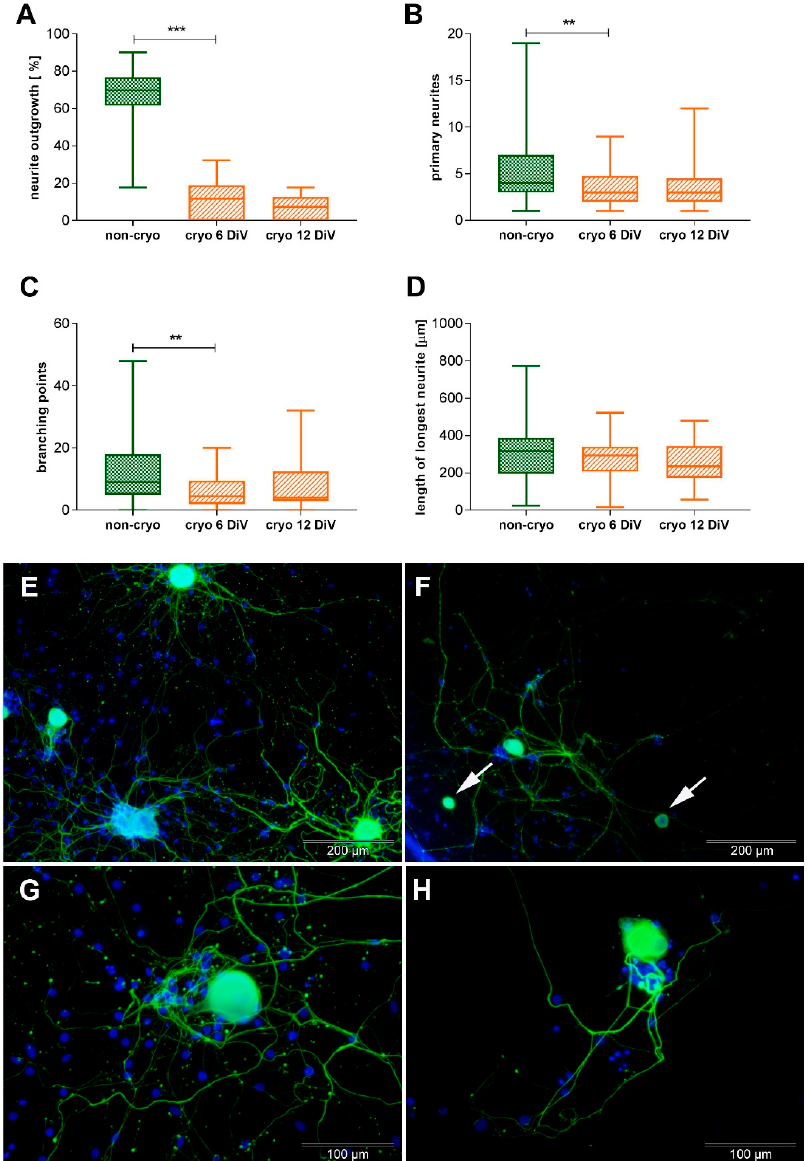
Figure 3. Comparative morphometric analysis of non-infected non-cryo (6 DiV) and cryo (6 and 12 DiV) neurons. A: Y axis: neurons showing neurite outgrowth [%]. Non-cryo cultures contain a higher percentage of neurons showing neurite outgrowth compared to cryo cultures. Non-cryo 6 DiV, cryo 6 DiV, and cryo 12 DiV: n = 24 wells. B: Y axis: number of primary neurites per neuron. Among the neurons showing neurite outgrowth, non-cryo neurons possess a higher number of primary neurites per neuron. Non-cryo: n = 72 neurons, cryo 6 DiV: n = 24 neurons, cryo 12 DiV: n = 37 neurons. C: Y axis: number of neurite branching points per neuron. Non-cryo neurons form a higher number of neurite branching points per neuron than cryo neurons. Non-cryo: n = 72 neurons, cryo 6 DiV: n = 24 neurons, cryo 12 DiV: n = 37 neurons. D: Y axis: length of longest neurite [ µ m] per neuron. Non-cryo and cryo neurons show no significant difference in the mean length of their longest neurite. Non-cryo: n = 72 neurons, cryo 6 DiV: n = 24 neurons, cryo 12 DiV: n = 37 neurons. E–H: Immunofluorescence-images of non-cryo ( E,G ) and cryo neurons ( F,H ) at 6 DiV; green = pan-NF, blue = bisBenzimide nuclear stain. More neurons without neurites ( F: arrows) can be found in cryo cultures. Cryo neurons generally show fewer and less branched neurites and smaller cell bodies ( F,H ) compared to non-cryo neurons ( E,G ). ** = p < 0.01, *** = p < 0.001. Employed statistical test: Mann–Whitney U-test. Pan-NF = pan-neurofilament, DiV = days in vitro, non-cryo = non-cryopreserved, cryo = cryopreserved. Graphs show median value, quartils, minimum and maximum